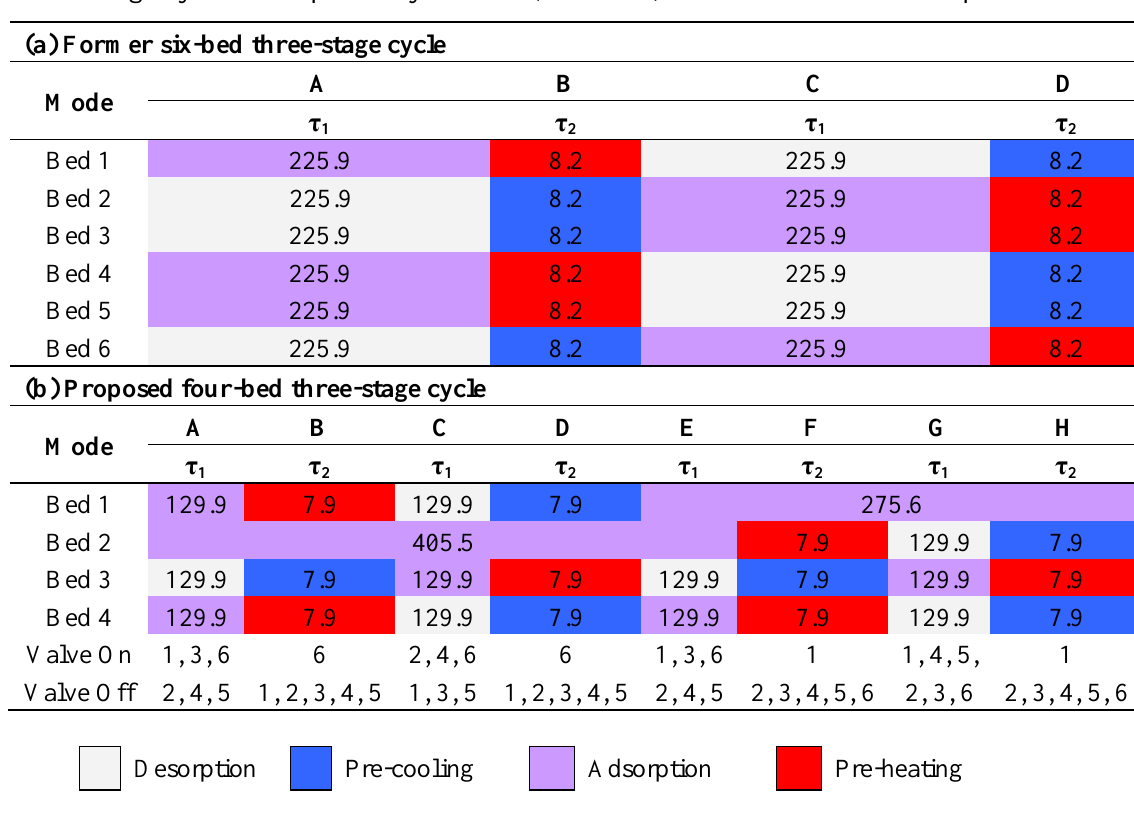
Table 1. Operation mode of former six-bed three-stage cycle and proposed four-bed three-stage cycle with optimal cycle time (in second) at 50 °C heat source